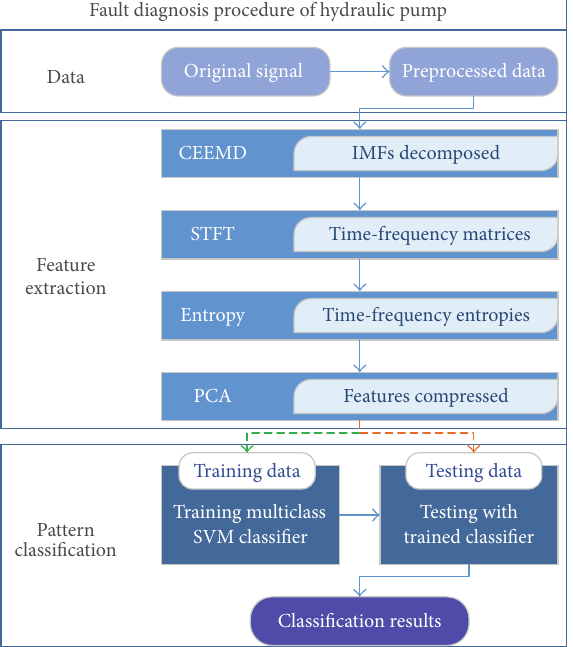
Figure 1: Entire fault diagnosis